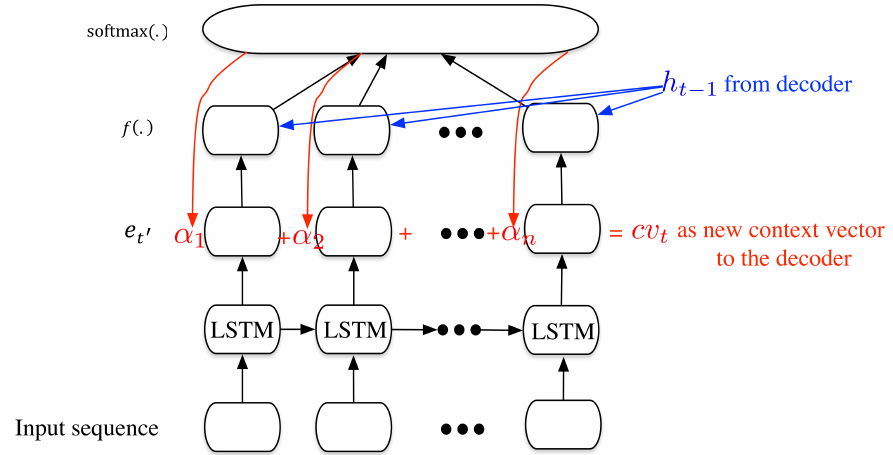
Figure 5. An illustration for the attention mechanism of the seq2seq